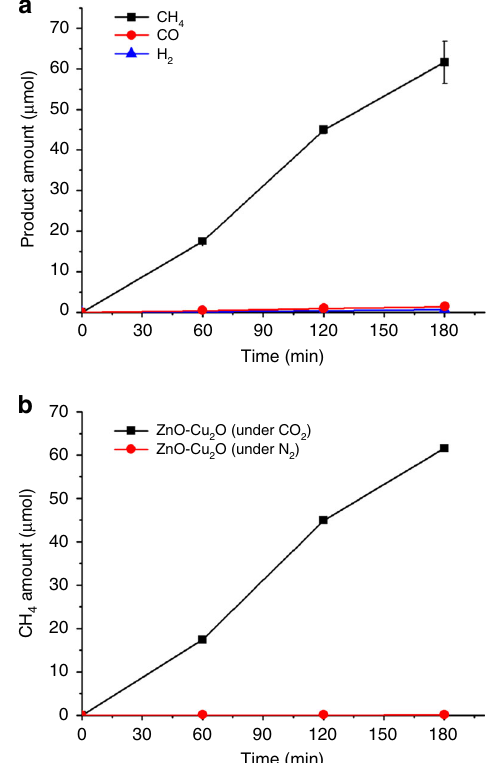
Fig. 2 Photocatalytic CO 2 conversion experiments. a Amounts of CH 4 (black), CO (red), and H 2 (blue) production, and b amounts of CH 4 production under CO 2 saturation (black) and N 2 bubbling (red) conditions using the ZnO-Cu 2 O catalysts as a function of the irradiation time. The reaction conditions ( a , b ) were catalyst amount 19 mg, pH = 7.4, and λ > 200 nm. The error bars were obtained from three independent